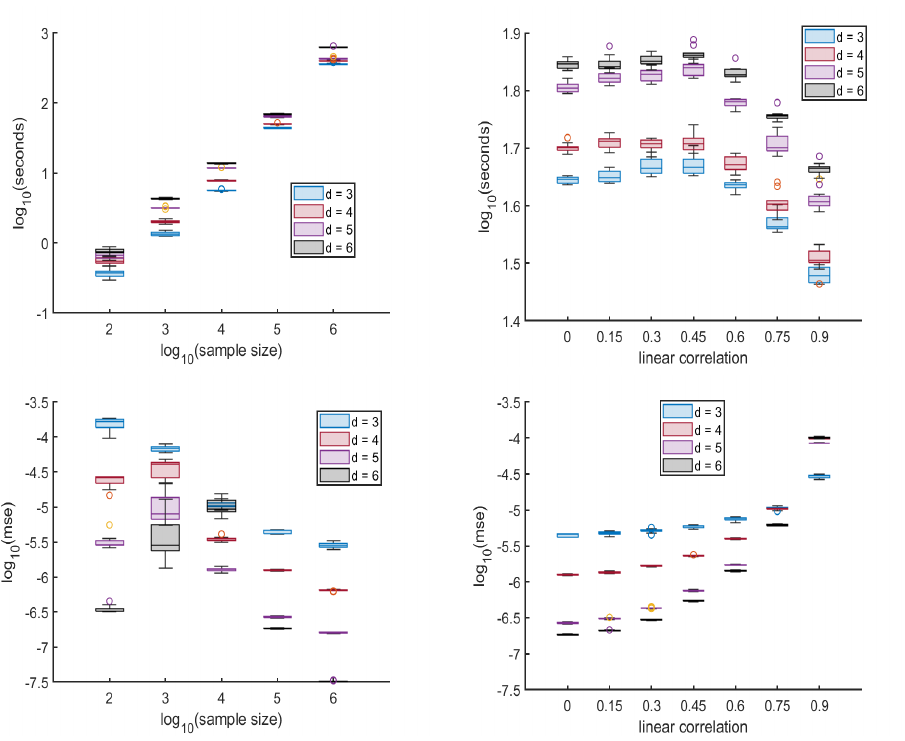
Figure 3. Performance benchmarks based on synthetic data from Cauchy and GMM. Computa- tion time ( top row ), MSE ( bottom row ), no correlation ( left column ), sample size of 100,000 ( right column